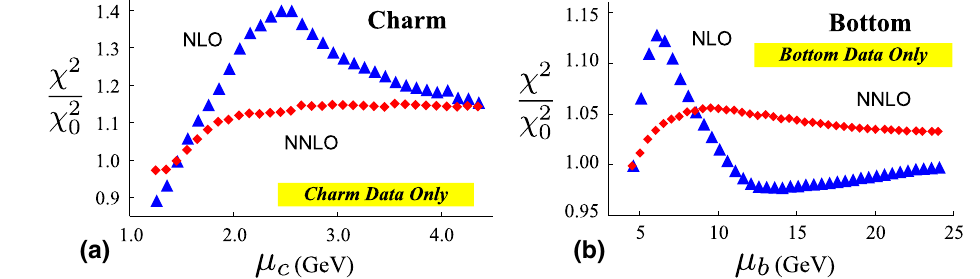
Fig. 10 The ratio ( χ 2 /χ 2 ) of partial χ 2 values (charm/bottom data 0 only) from Figs. 6 and 8 as a function of the a charm and b bottom matching scale μ c , b in GeV. χ 2 is the χ 2 value for μ m equal to the 0